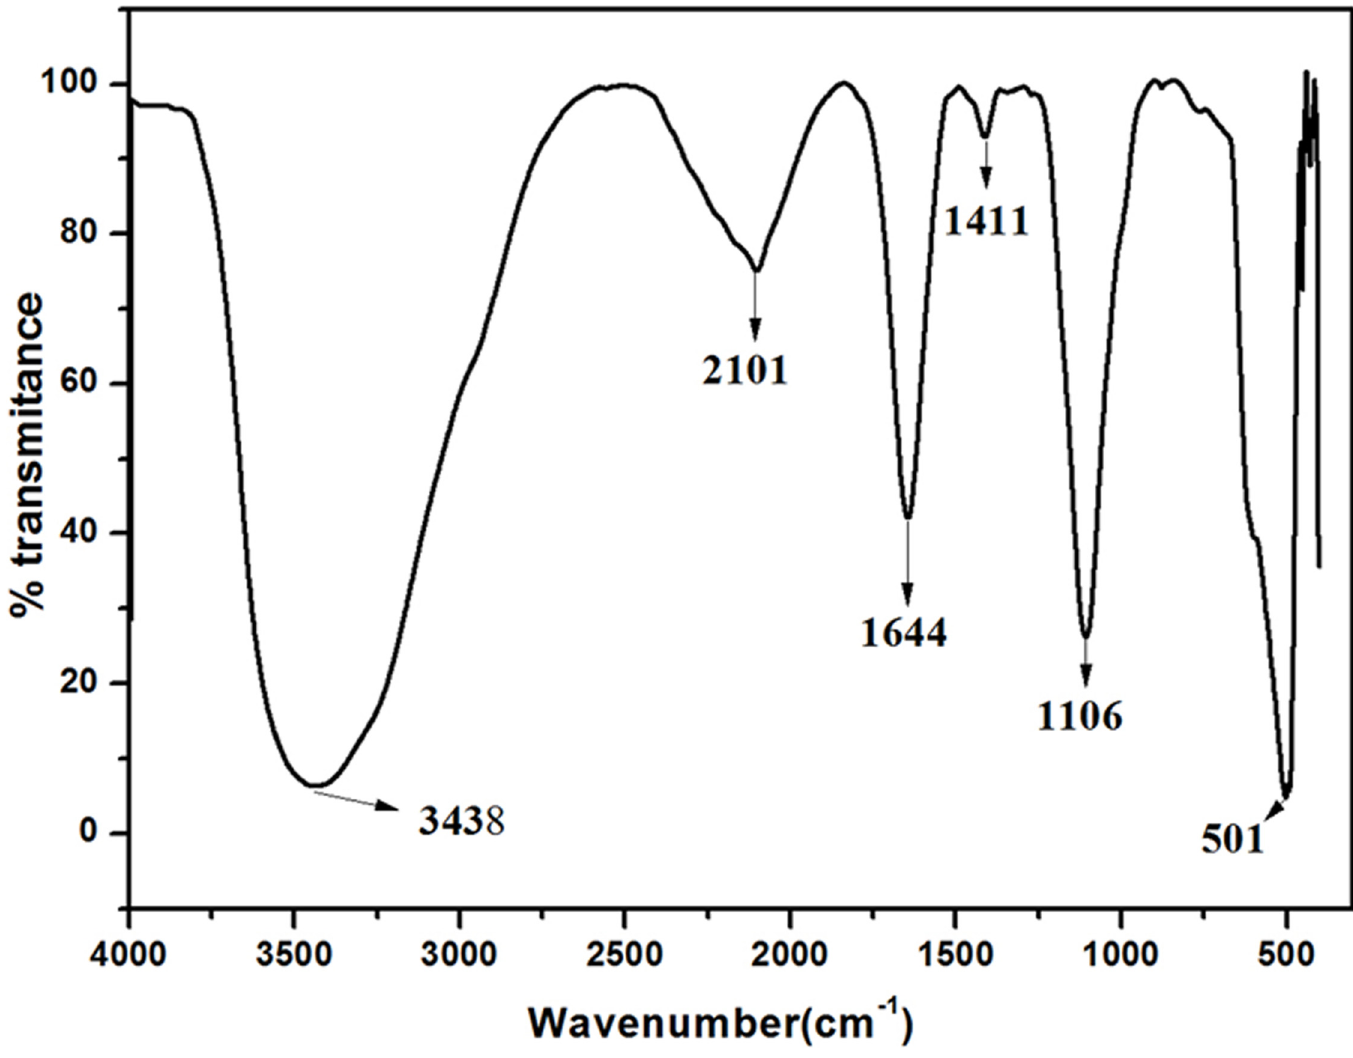
Fig 1. Infrared Spectrum analysis of